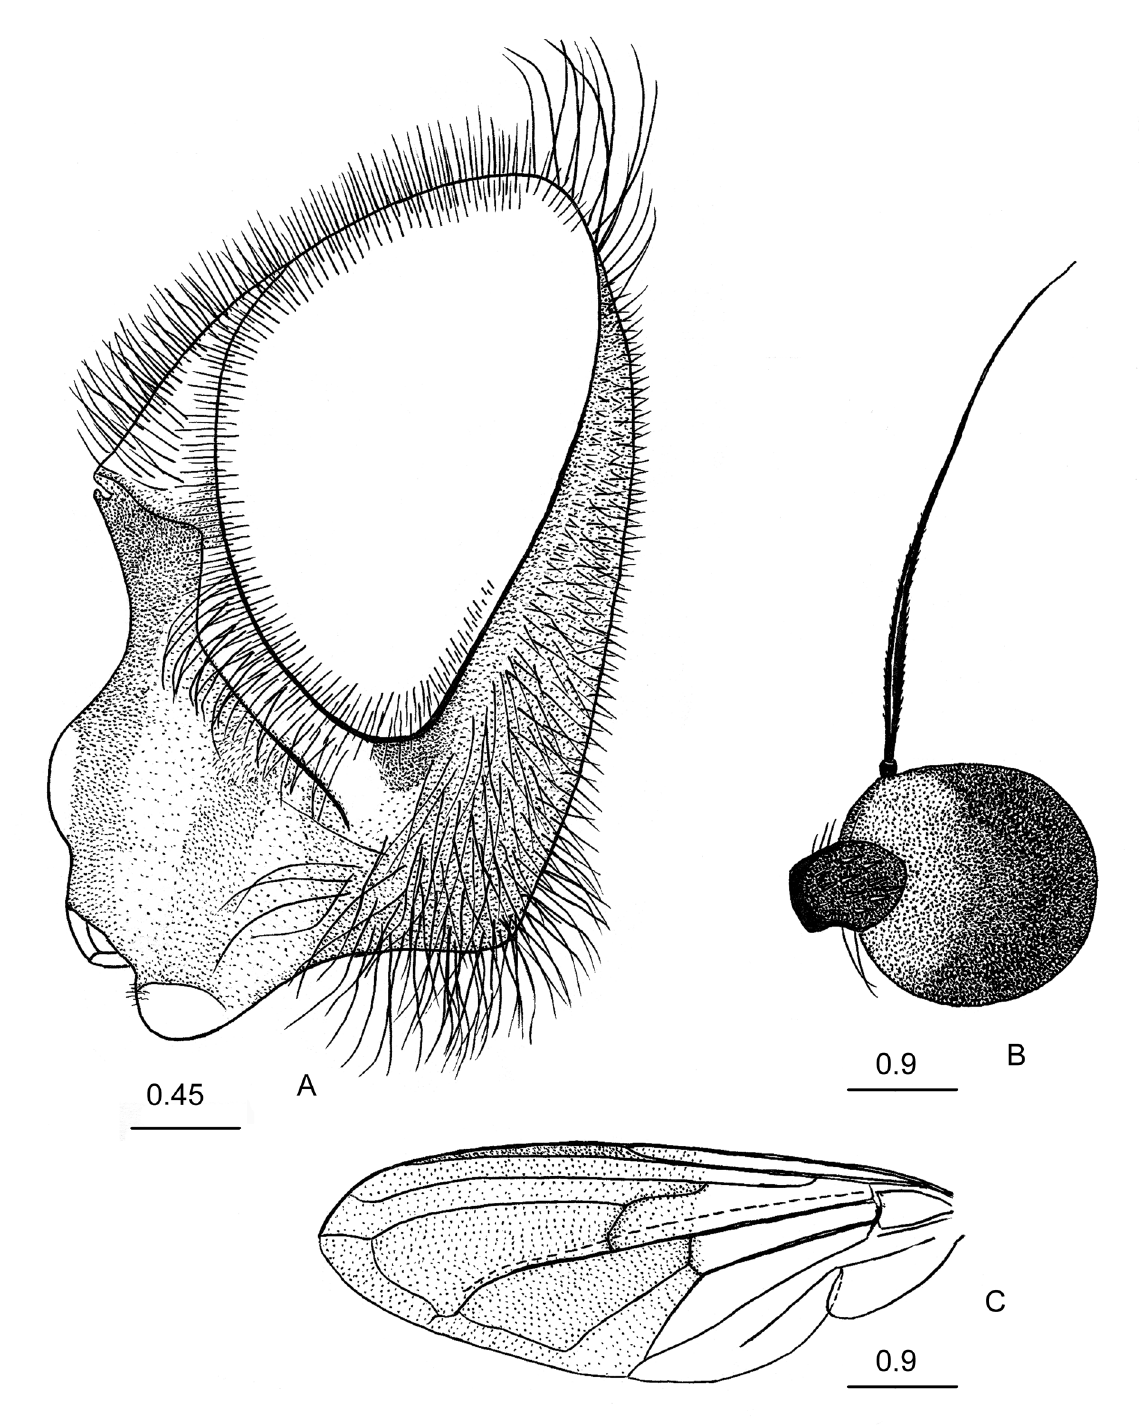
Fig. 35. Cheilosia ( Floccocheila ) leucozonoides sp. nov., holotype, ♀ (CNC). A . Head, lateral view. B . Antenna, lateral view of pedicel and basoflagellomere. C . Wing. Scale bars indicated in